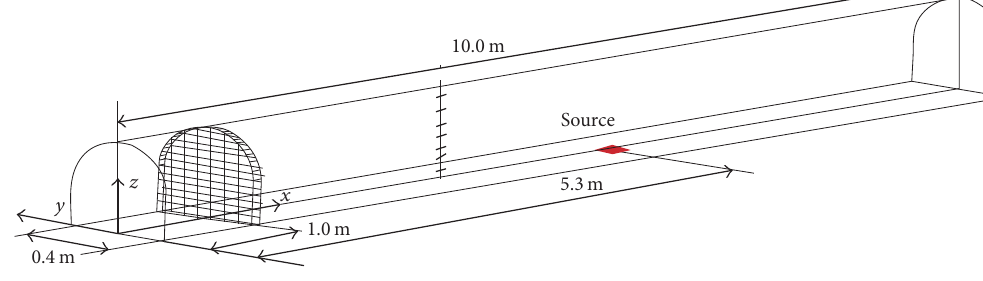
Figure 4: Configuration of reduced tunnel.